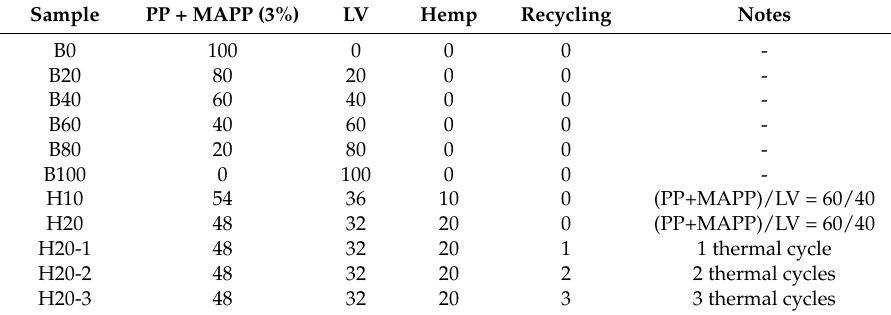
Table 1. Blend formulations. For all the samples, 3% of PP-MAPP was